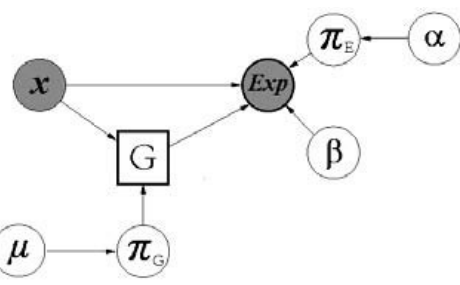
Figura 5 – Modello grafico di ME bayesiano.